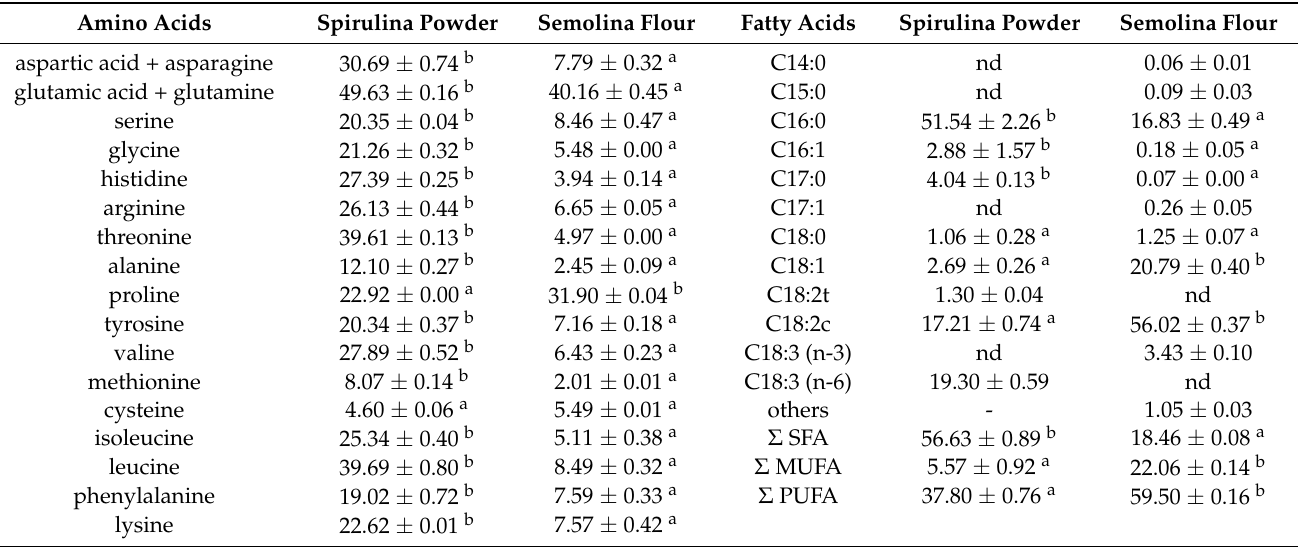
Table 3. Amino acids [mg/g dry matter] and fatty acids [%] profile of the spirulina powder and semolina flour.